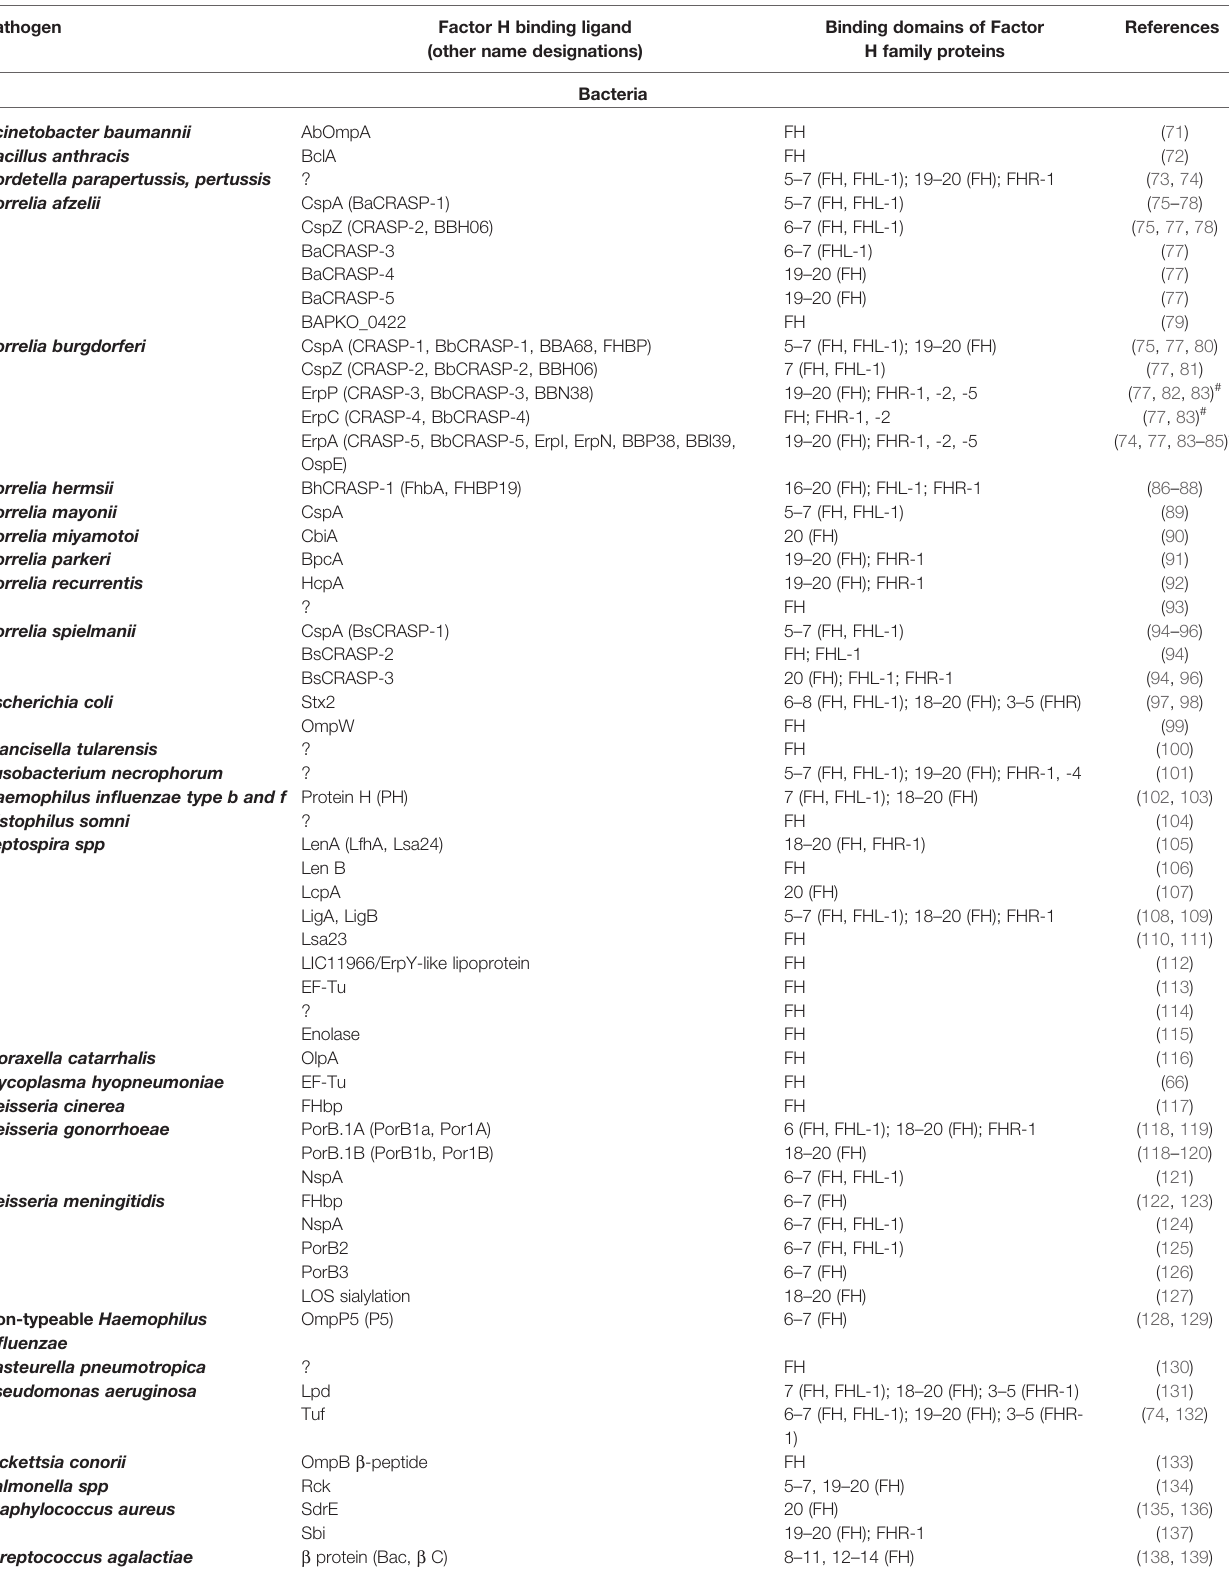
TABLE 1 | Pathogen interactions with Factor H family